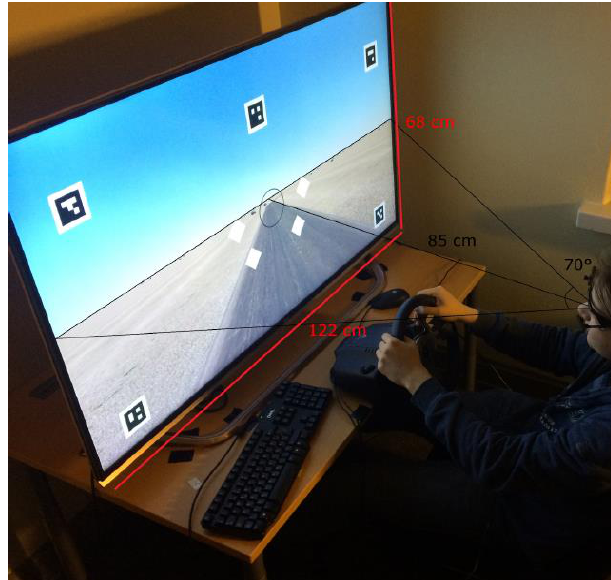
Figure 1. The experimental set-up. During the exper- iment, the display was the only light